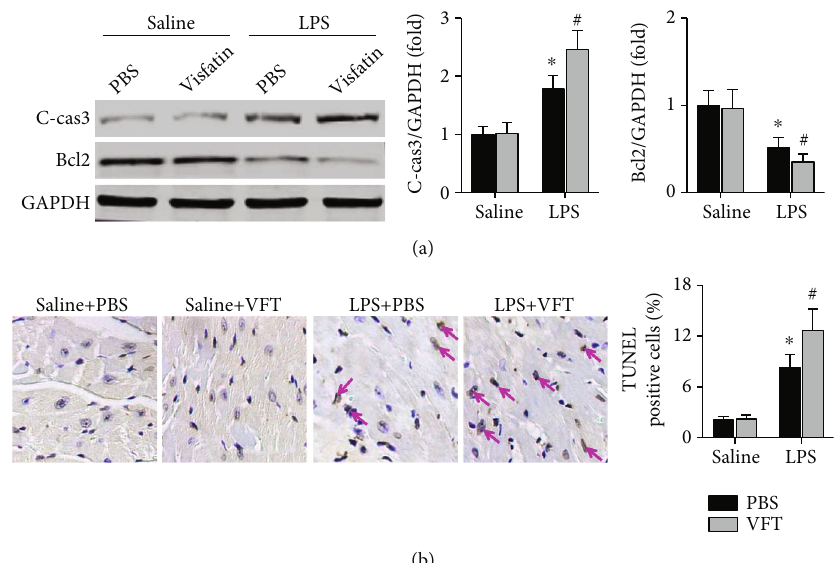
Figure 4: E ff ects of visfatin on LPS-induced myocardial cell apoptosis in mice. (a) The expression of cleaved caspase3 and Bcl2, apoptosis- related proteins, was detected. (b) TUNEL-positive cells were examined. N = 5 − 6 in each group. ∗ p < 0 : 05 vs. the saline+ PBS group. # p < 0 : 05 vs. the LPS +PBS group. VFT means